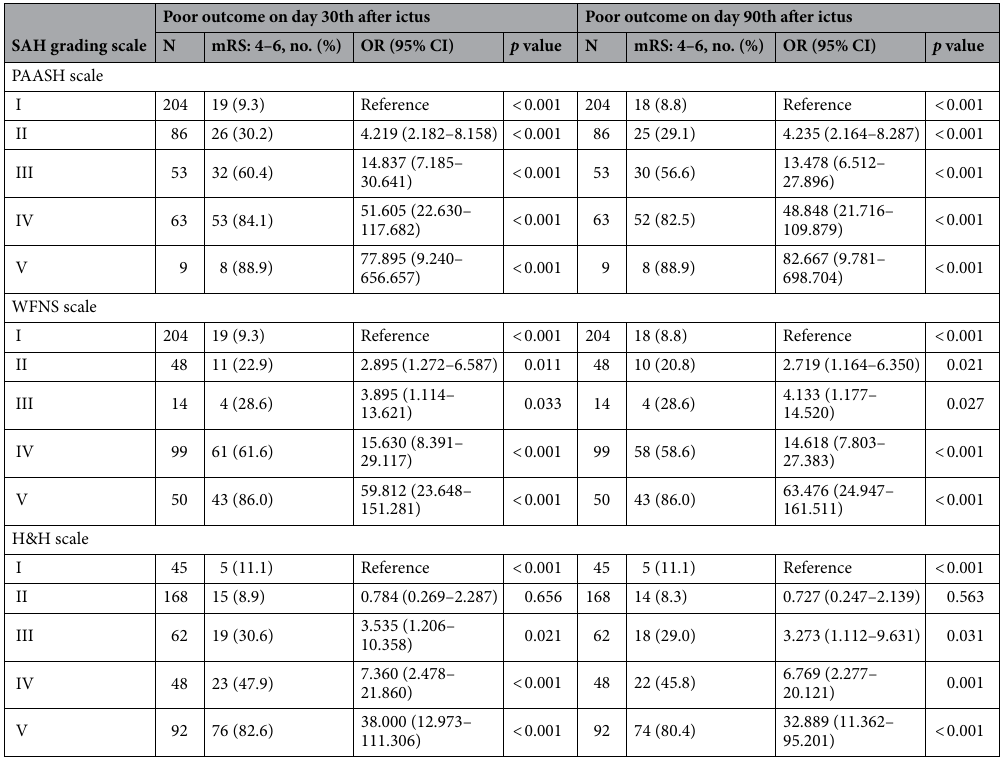
Table 4. OR for a poor outcome (mRS of 4 to 6) for the SAH grading scales. CI confidence interval, H&H Hunt and Hess, mRS modified Rankin Scale, N total number of patients for each grade, no. number, OR odds ratio, PAASH Prognosis on Admission of Aneurysmal Subarachnoid Haemorrhage, SAH subarachnoid haemorrhage, SD standard deviation, WFNS World Federation of Neurological